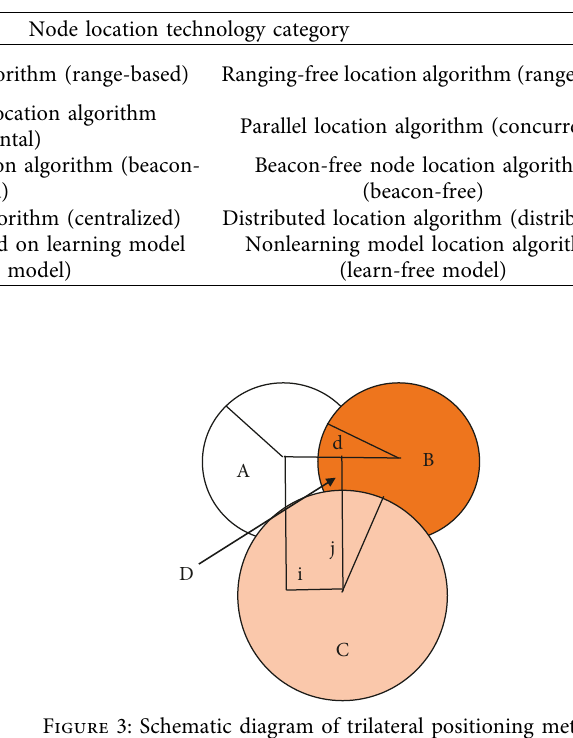
Figure 2: Positioning process of the wireless sensor network. Table 1: Classification of node positioning technology.